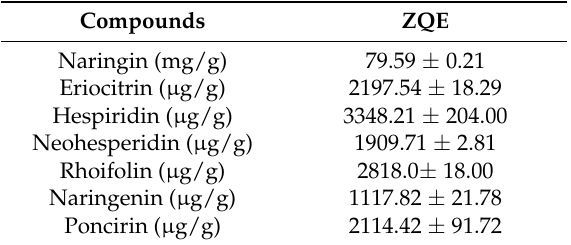
Table 2. Seven flavonoids compounds concentrations in the extract of ZQE a .